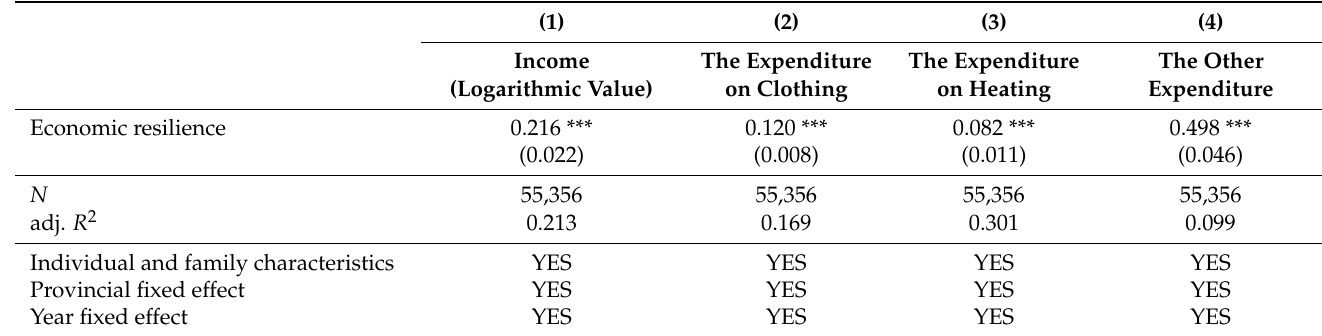
Table 9. The rise of income and family